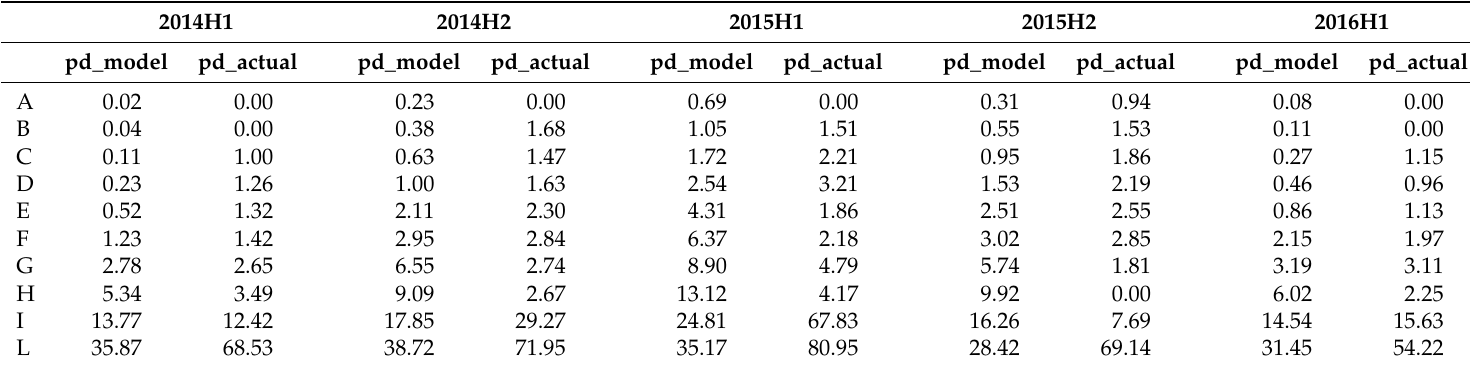
Table A3. The table compares default probabilities estimated by the regression model ( pd_model ) and default frequencies ( pd_actual ) across the pool cut-off dates. The values of the two statistics are close, especially for the intermediate rating